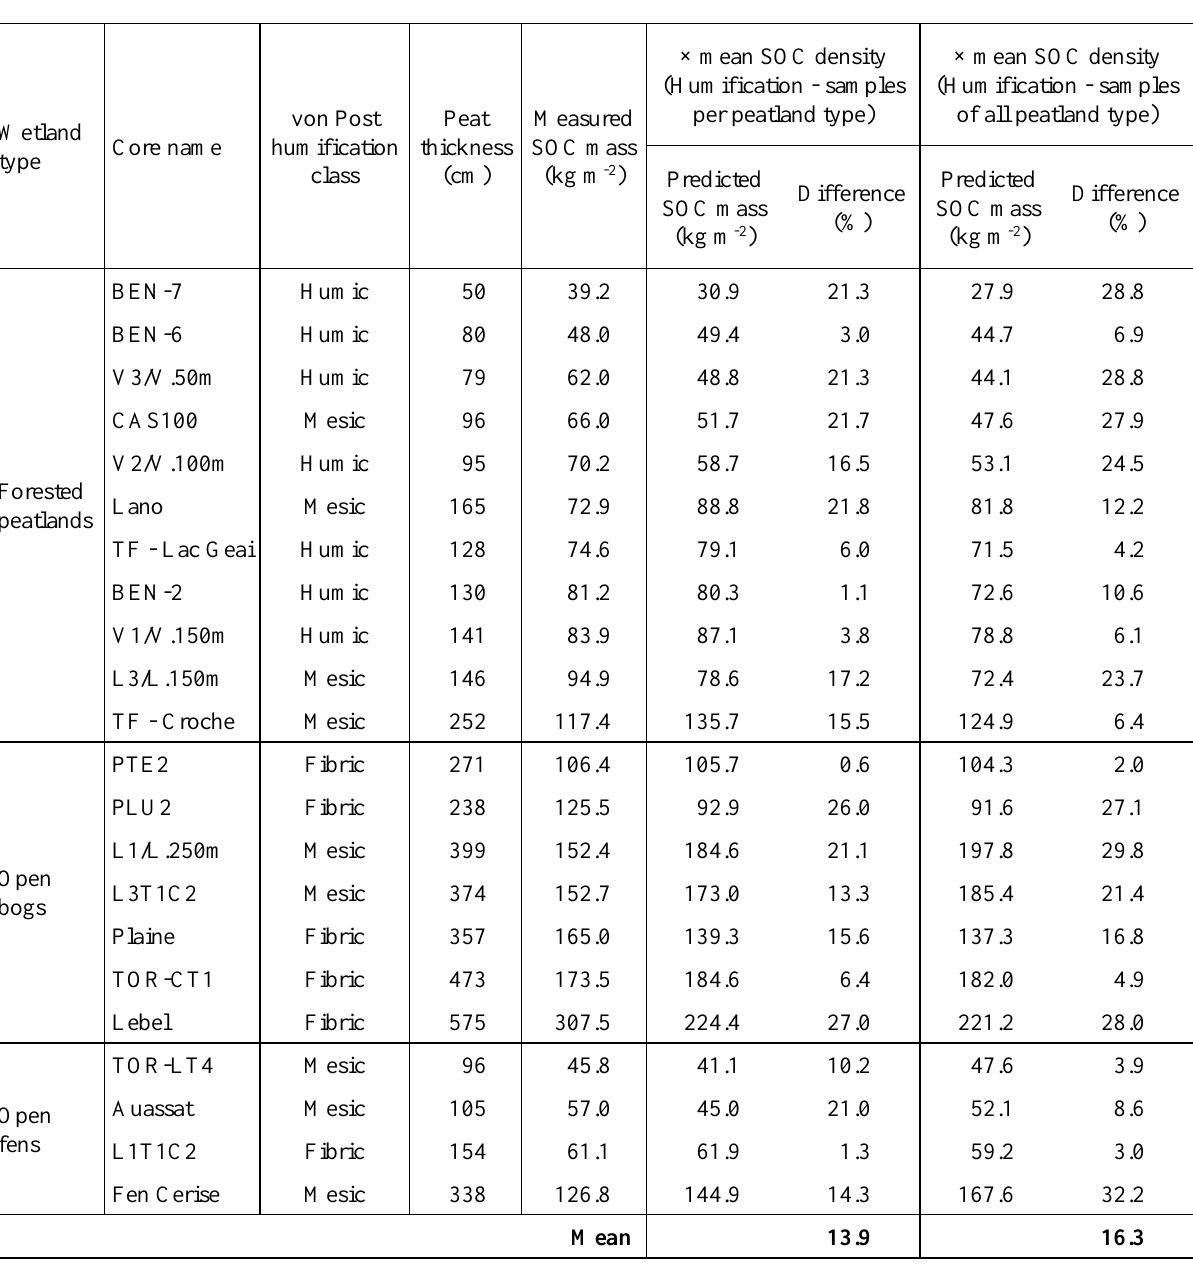
Table 3. SOC mass estimates using the mean carbon density calculated for each degree of humification.